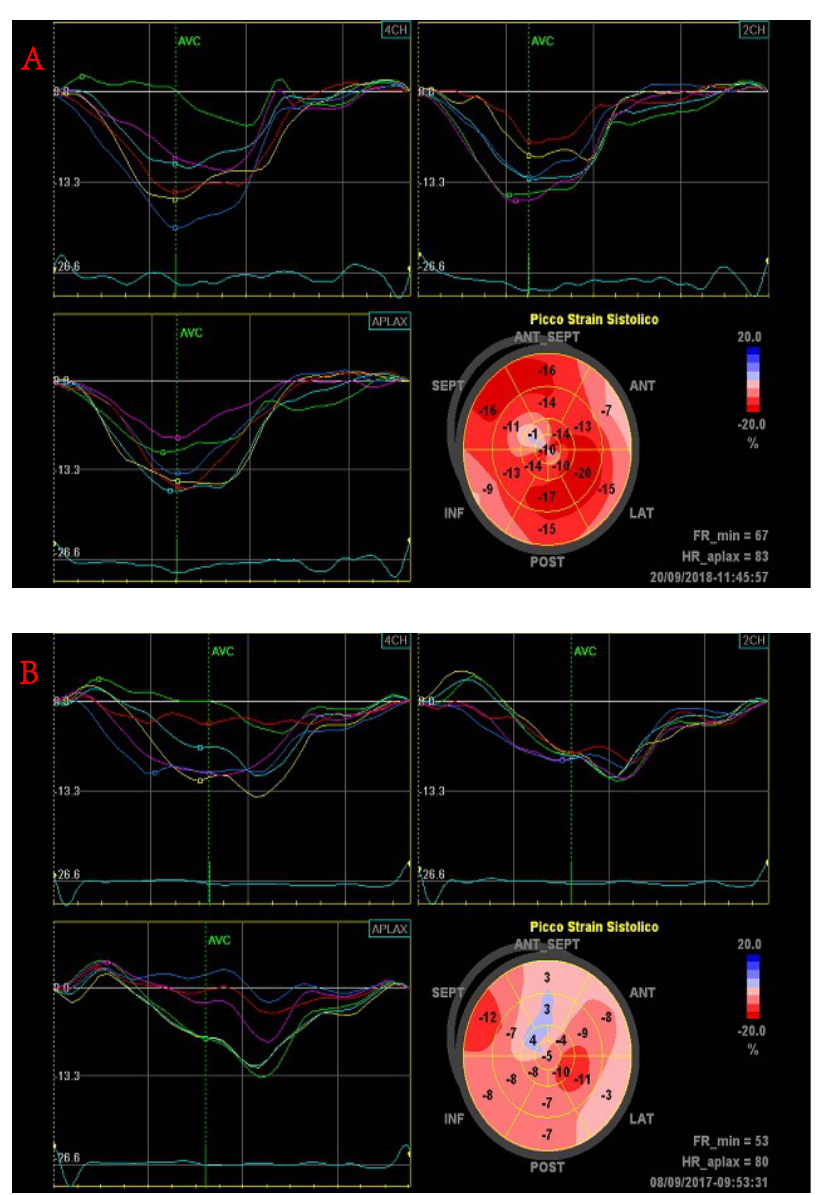
Figure 4. Evolution of global longitudinal strain in a patient with acute cellular rejection. Note the normal value at baseline ( A ) and the overall reduction during the rejection episode ( B